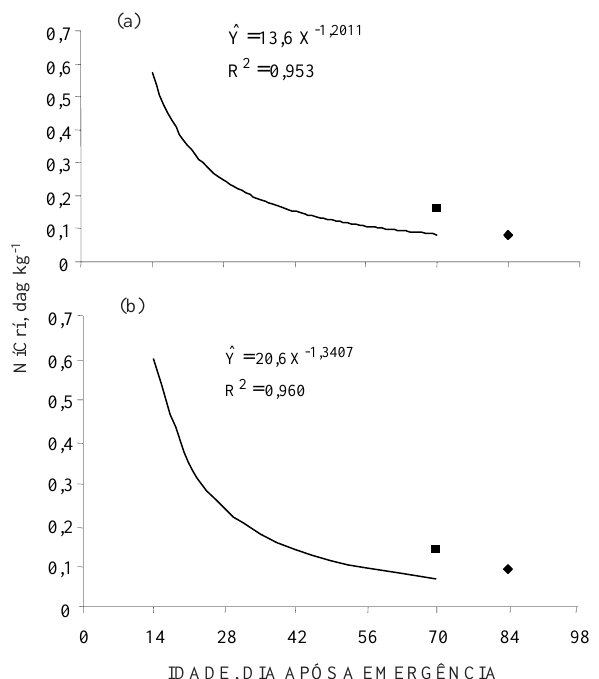
Figura 4. Variação dos níveis críticos de fósforo na parte aérea, considerando a idade das plantas de B. decumbens (a) e de P. maximum (b). Os pontos correspondem aos valores de rebrotação de 28 ( n ) e 42 ( u ) dias após 42 dias de crescimento